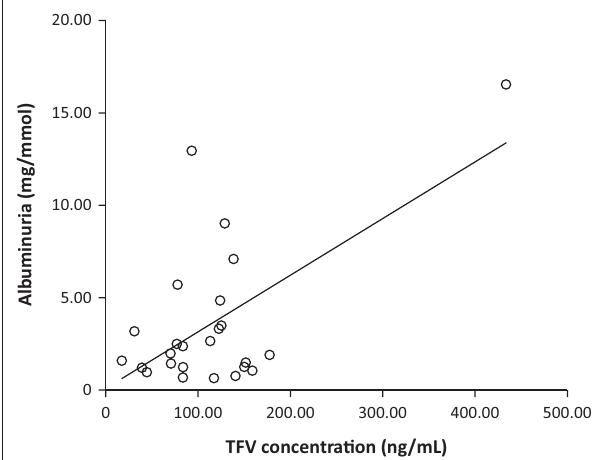
FIGURE 1: Regression plot of association between plasma tenofovir (TFV) concentration and albuminuria in HIV-infected women, age and BMI as fixed factors (adjusted r 2 = 0.339; p =